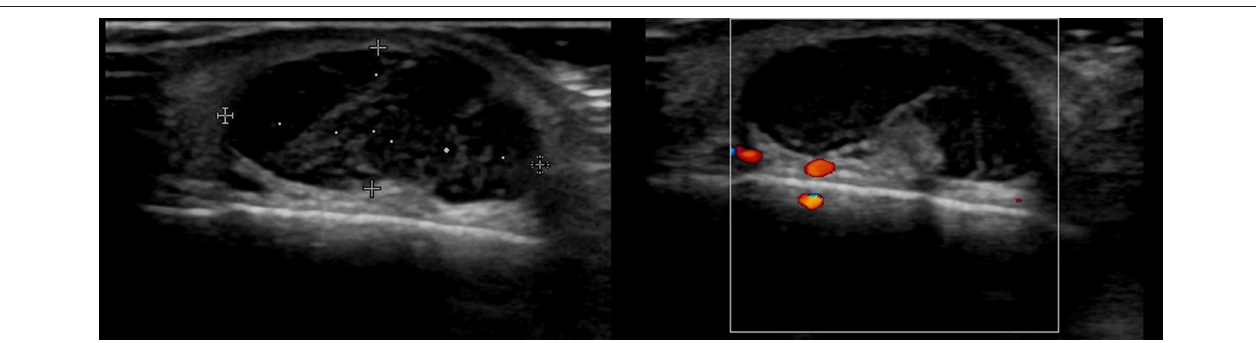
FIGURE 3 | Ultrasound image of trichilemmal